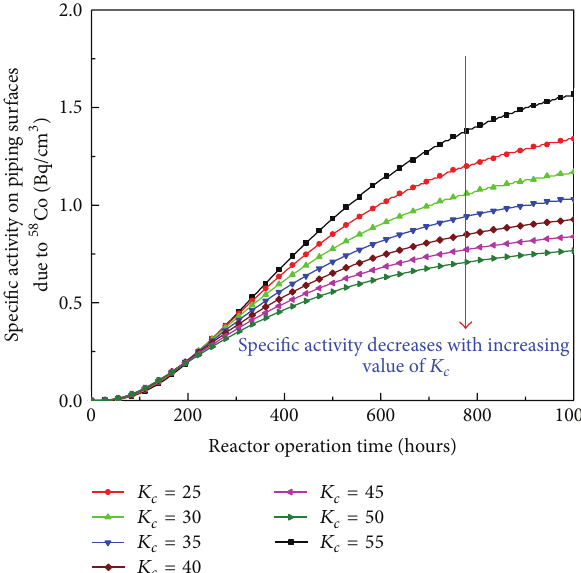
Figure 5: Variation in specific activity of 58 Co in primary coolant of PWR with different values of 𝐾 𝑐 .